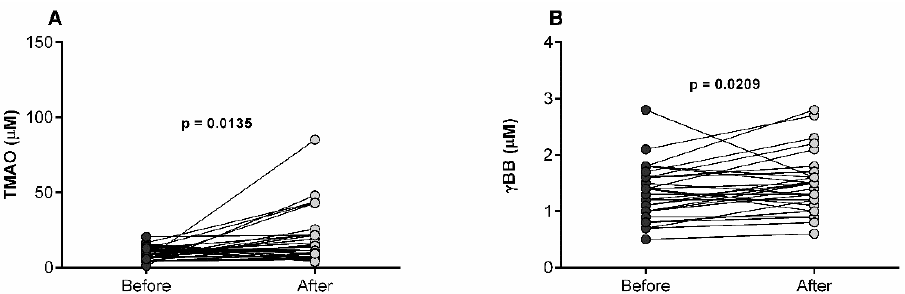
Figure 1. Serum TMAO ( A ) and γBB ( B ) levels in type 2 diabetic subjects at baseline and follow-up. Each pair of symbols with a line represents a participant before and after glycemic control. Wilcoxon matched-pairs signed rank test was performed to compare data.